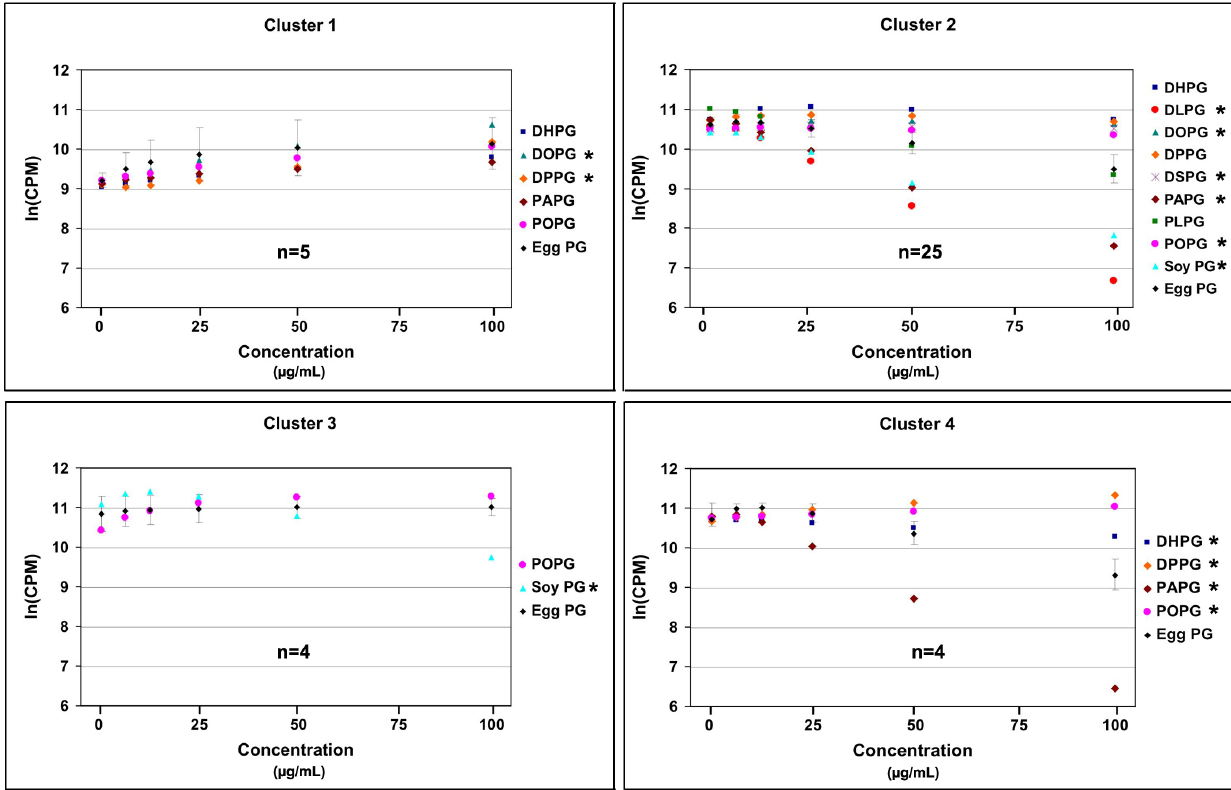
Figure 4. Comparison of Effects of PG Species on Keratinocyte Proliferation. Based on the regression line of the comparative egg PG data, Cluster 1 represents the experiments with a linear increasing relationship between ln(CPM) and ln(concentration) of egg PG, Cluster 2 represents the experiments with a non-linear decreasing relationship between ln(CPM) and ln(concentration), Cluster 3 represents the experiments with a flat, quadratic relationship between ln(CPM) and ln(concentration), and Cluster 4 represents the experiments with a decreasing step function between ln(CPM) and ln(concentration), respectively. Those PG species exhibiting a statistically significant difference from egg PG (either a greater or lesser effect) are marked by asterisks. The number of different experiments for which the egg PG comparator was performed is